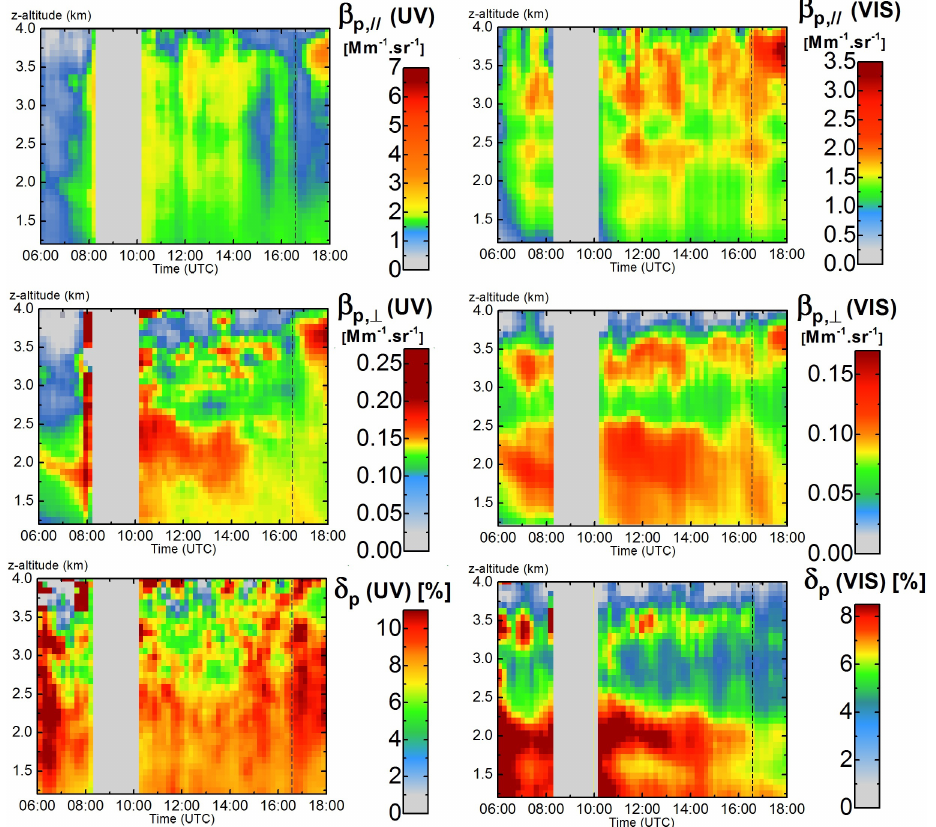
Fig. 9. Time–altitude maps of β p ,// , β p , ⊥ and δ p in the UV ( λ 1 =355nm, left three panels) and in the VIS ( λ 2 =532nm, right three panels) on 18 October 2011 at Lyon. The grey band corresponds to clouds which prevented retrieving the β p ,// , β p , ⊥ , δ p coefficients. Dashed lines correspond to Fig. 10, case study at